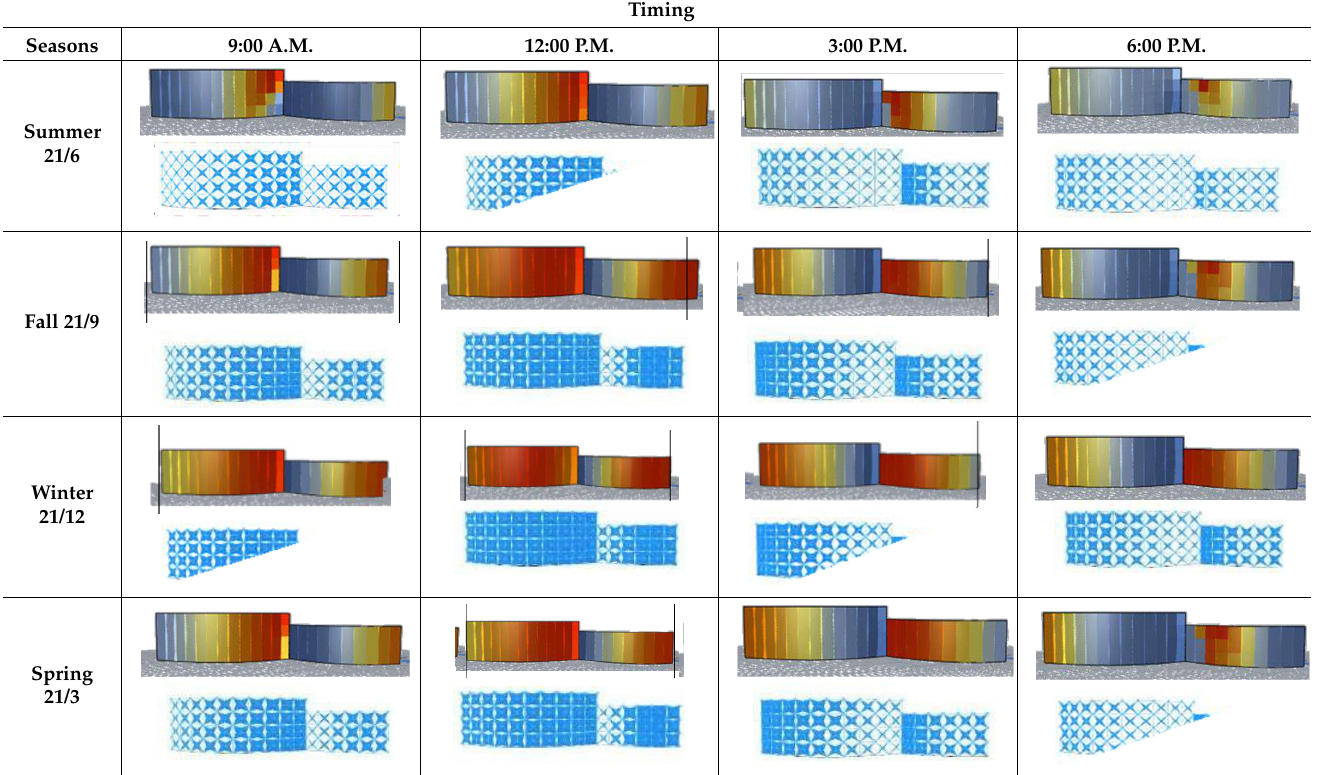
Table 5. Optimization process based on solar radiation .